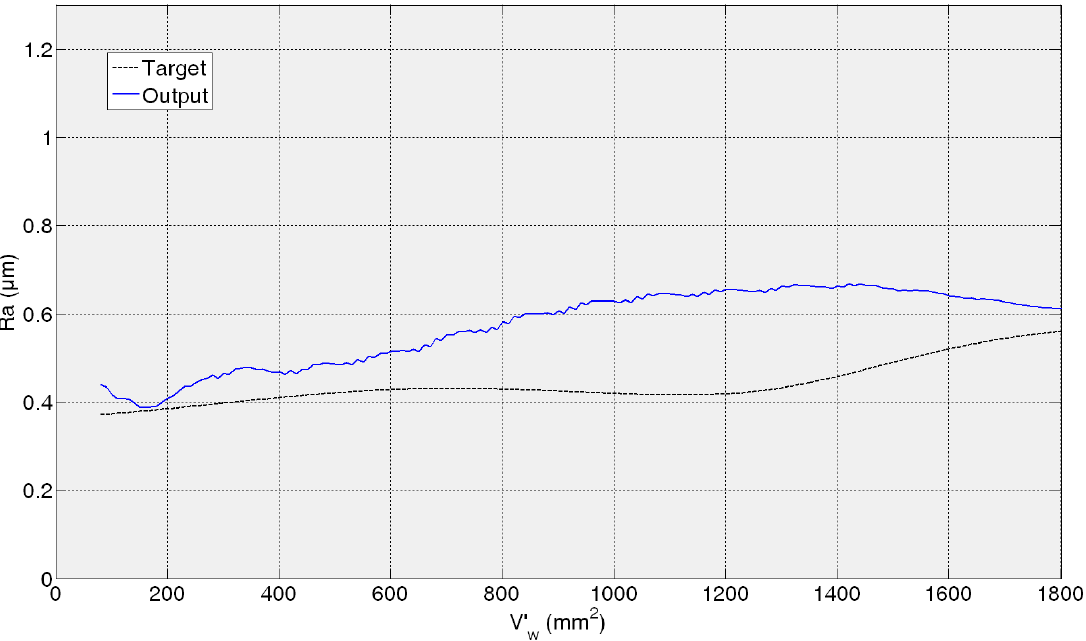
= 60 and Q' = 1 grinding s